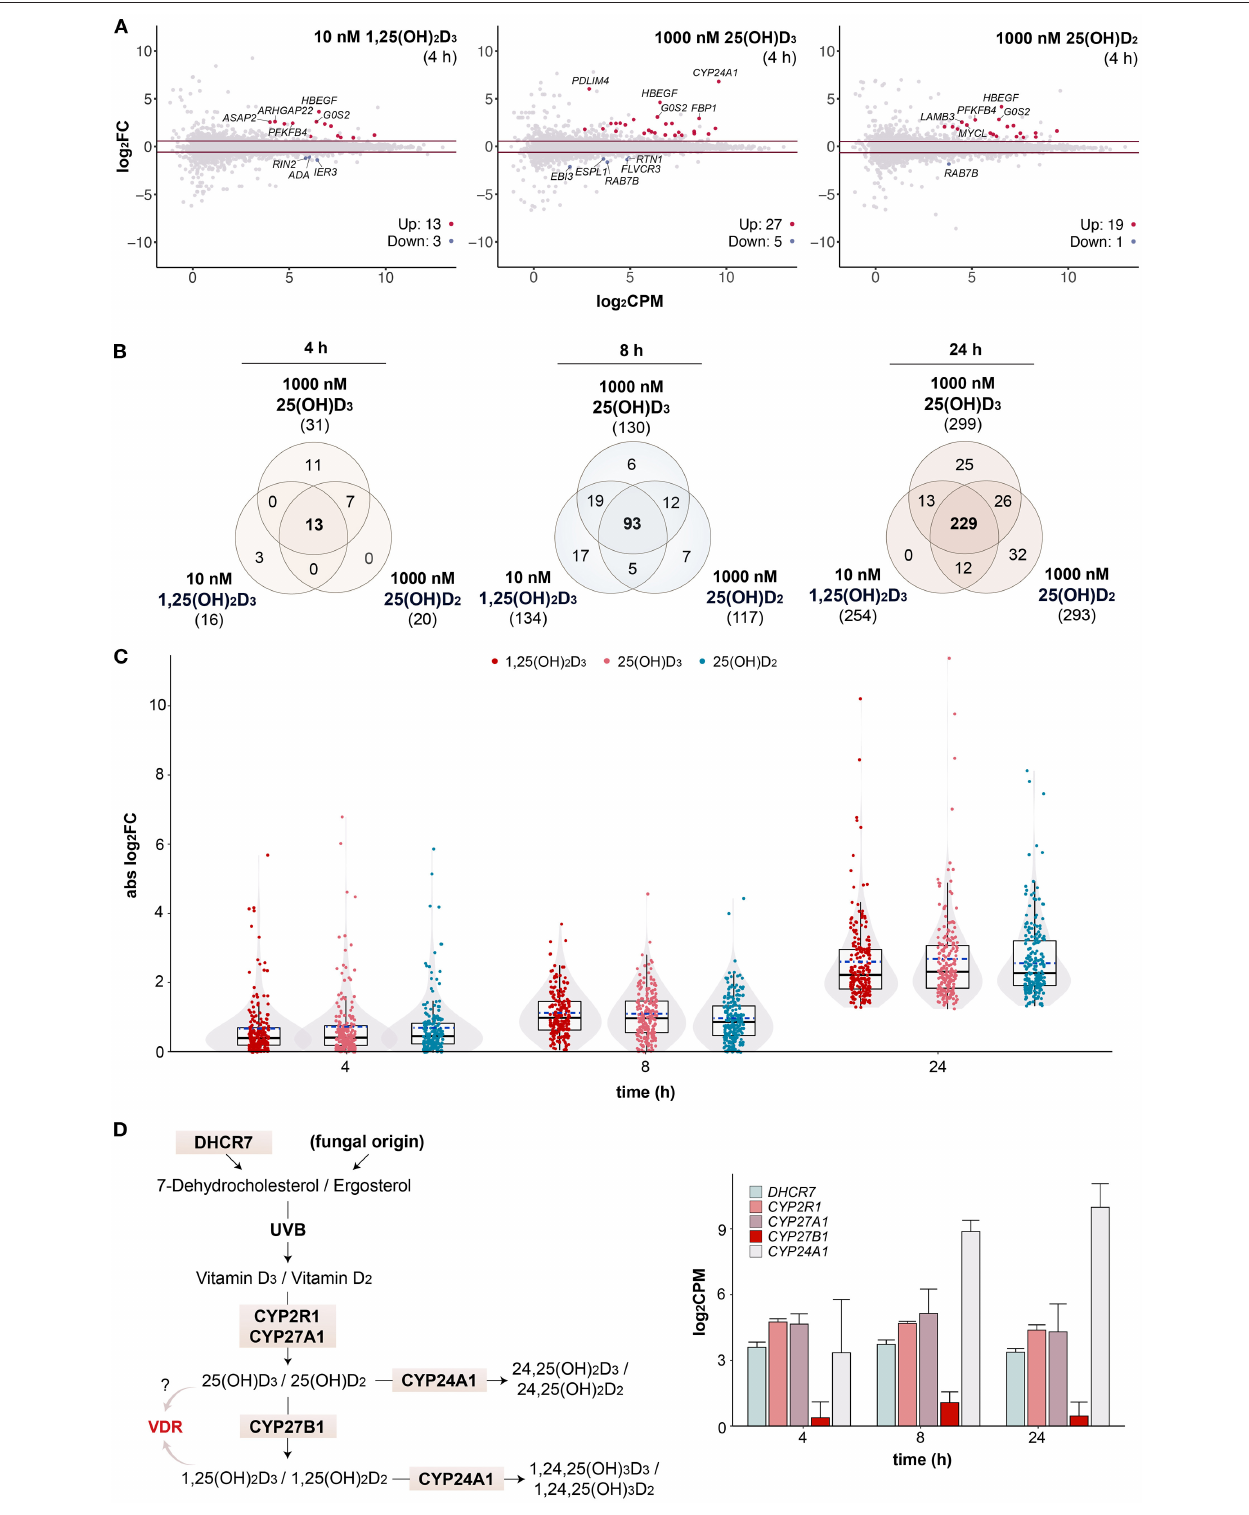
FIGURE 3 | Changes in transcriptional profiles over time. MA plots show early gene expression changes in PBMCs treated for 4 h with 10 nM 1,25(OH) 2 D 3 , 1000 nM 25(OH)D 3 or 1000 nM 25(OH)D 2 in comparison to solvent (0.1% EtOH, i.e., time-matched control) (A) . For each gene, difference in expression (log 2 FC) between